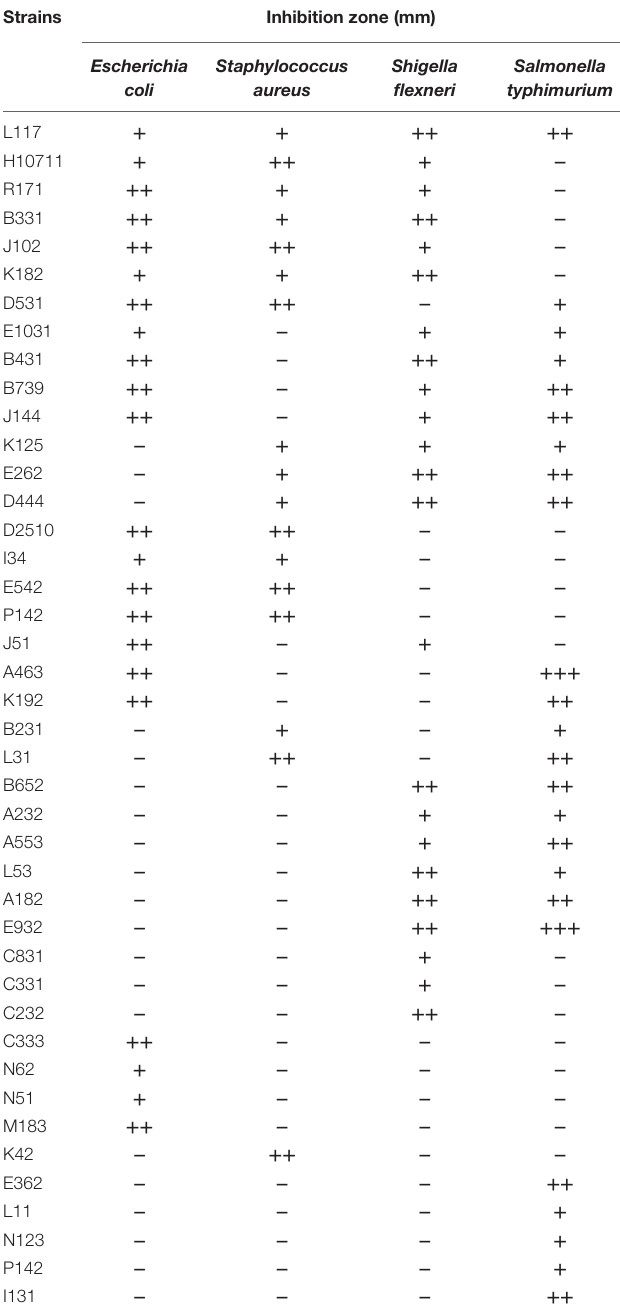
TABLE 1 | Inhibitory spectrum of L. plantarum strains.